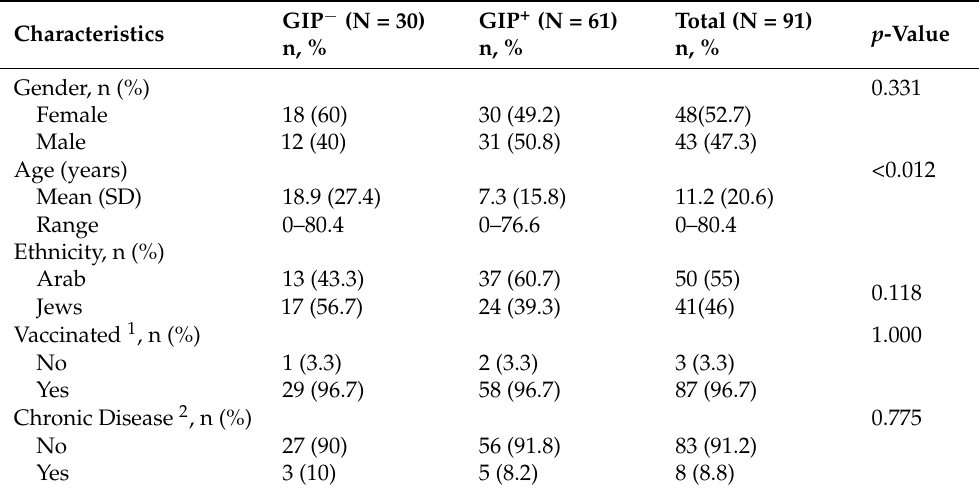
Table 1. General demographic and clinical data of study participants.